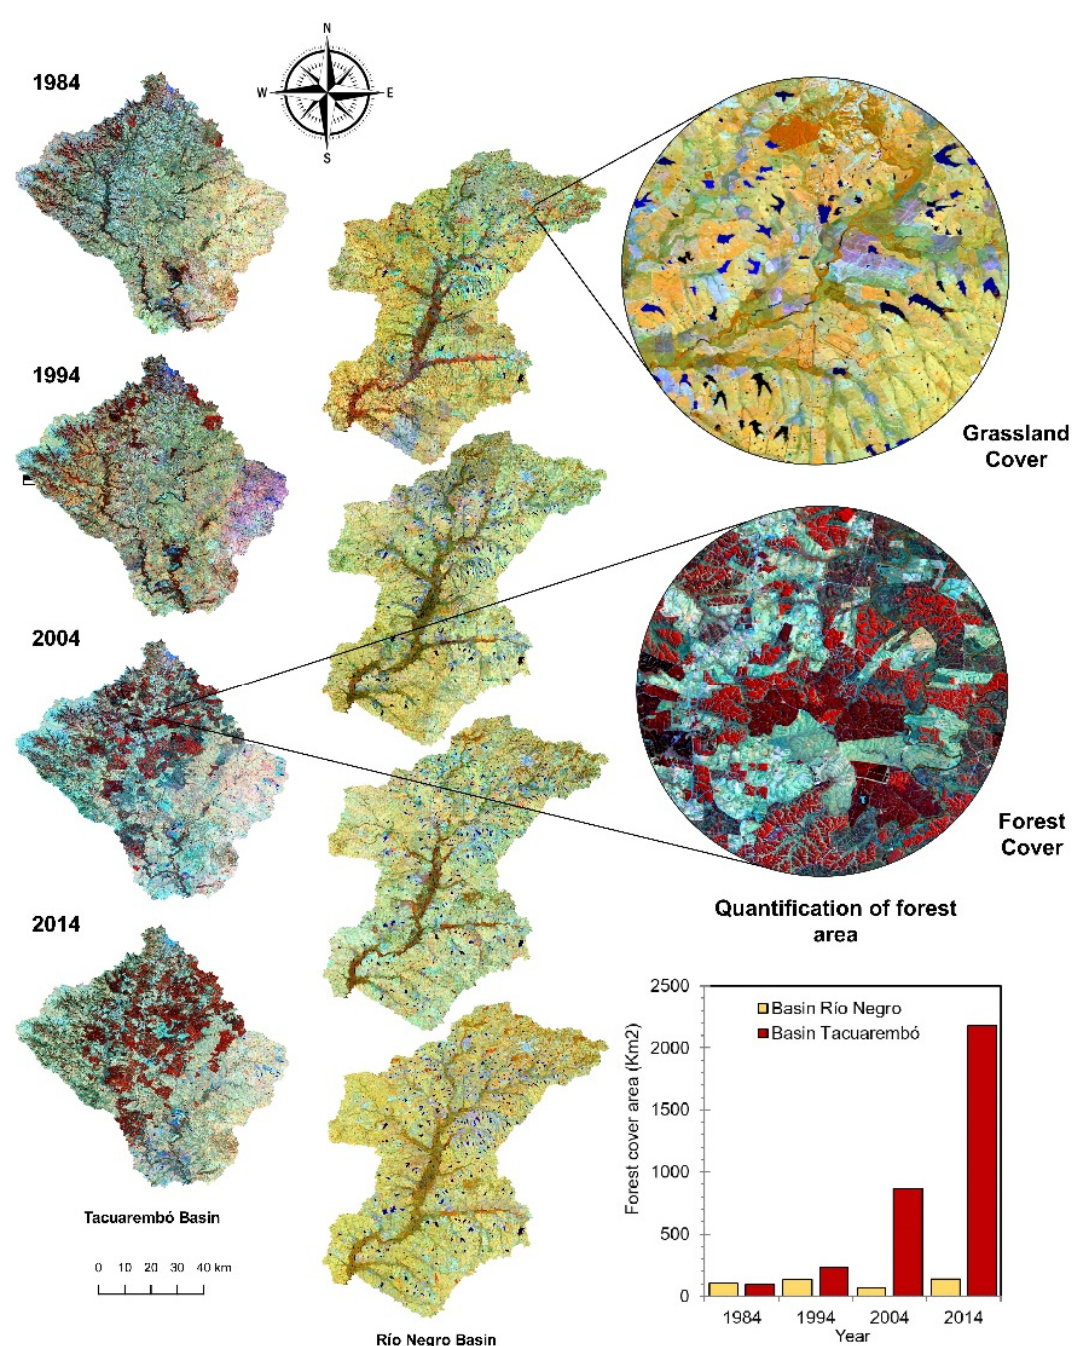
Figure 4. Analysis of the spatial dynamics of vegetation of four moments in the period 1984, 1994, 2004, and 2014. The images correspond to the Landsat 5 TM (1984, 1995, and 2005) combination of RGB 4–5–3 bands, and Landsat 8 OLI (2014) with a combination of RGB 5-6-4. The bar graph corresponds to the increase in the forested area, carried out by supervised classification in both basins.